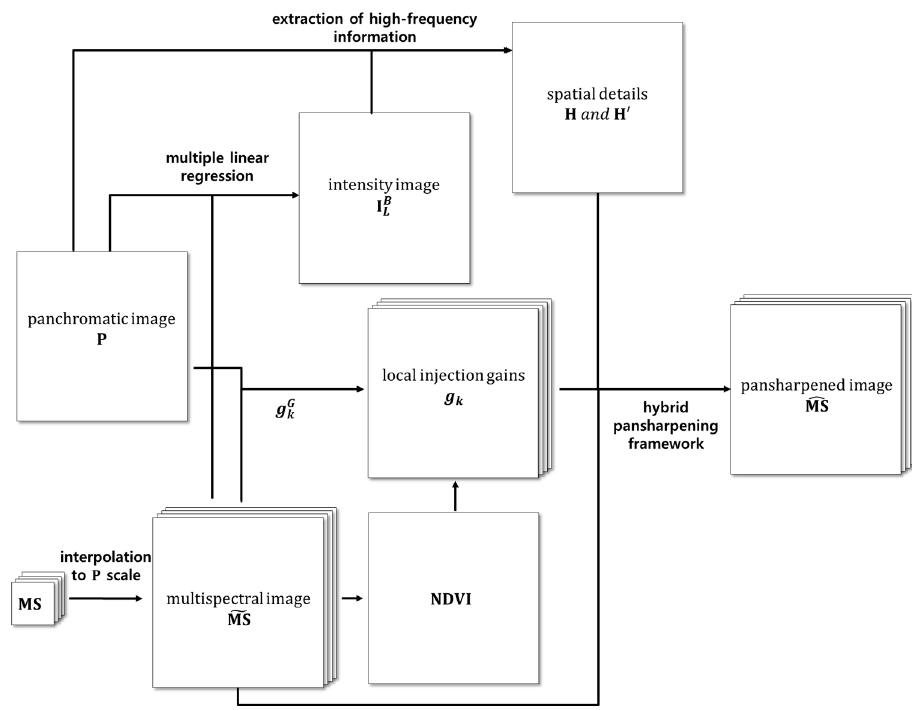
Figure 1. Workflow of the proposed pansharpening methodology.